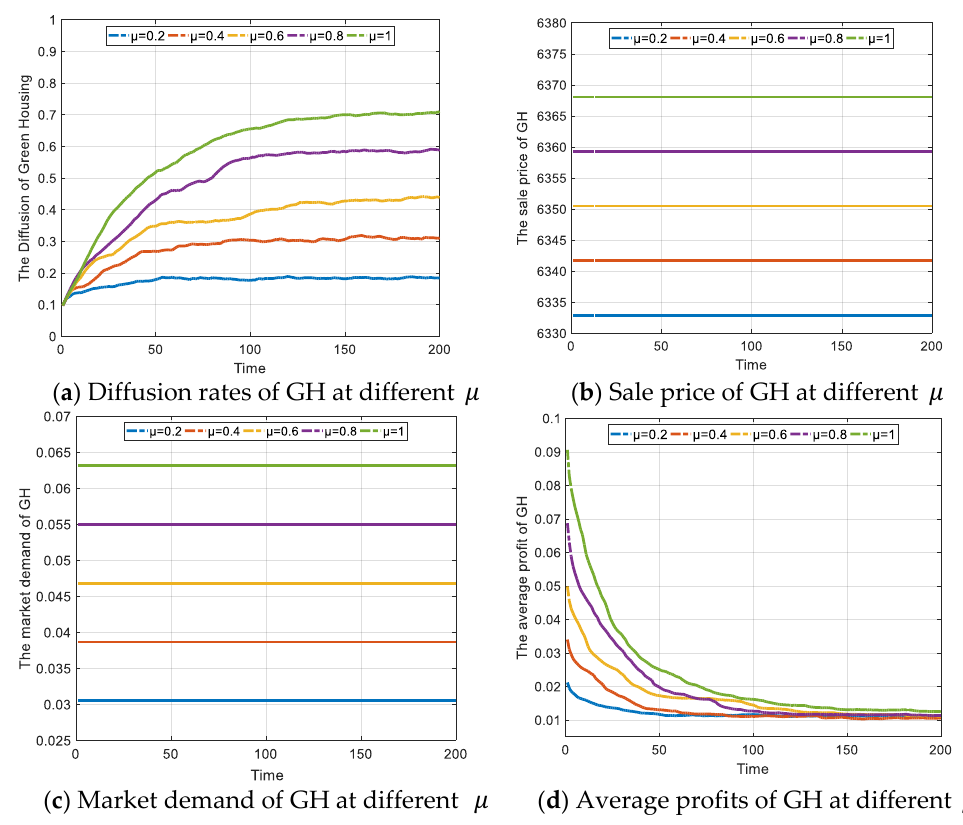
Figure 6. The effect of consumers subsidy policy on GH diffusion (Unit: CNY). Table 7. The diffusion rate of GH with different µ